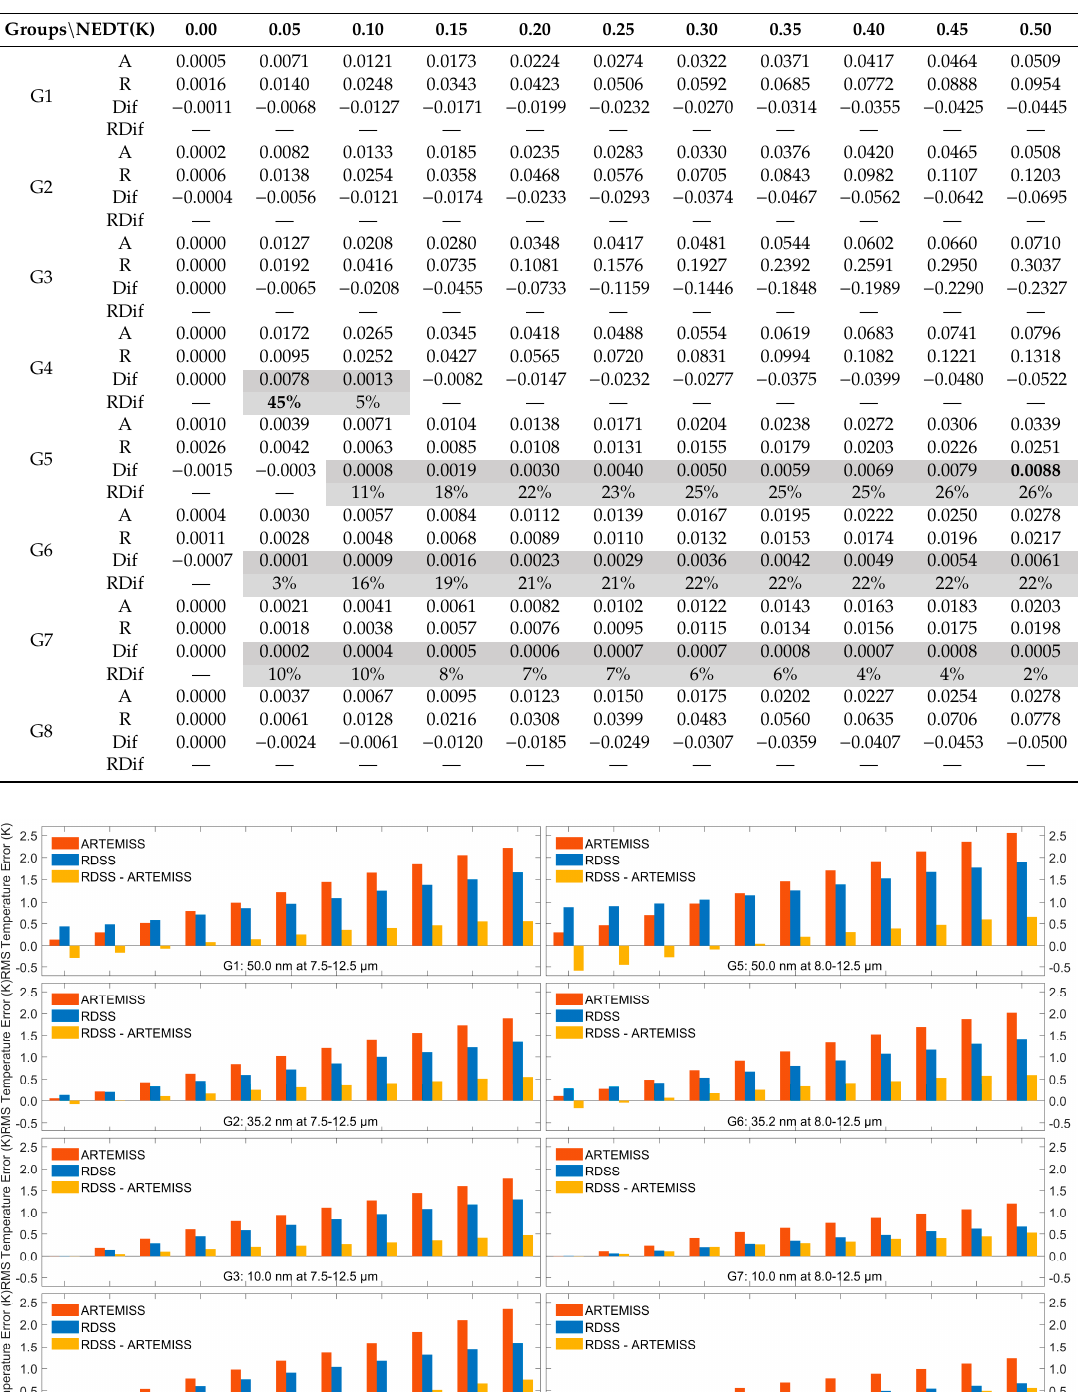
Table 4. The retrieved LSE RMSE for RDSS and ARTEMISS and their di ff erences. Groups \ NEDT(K)